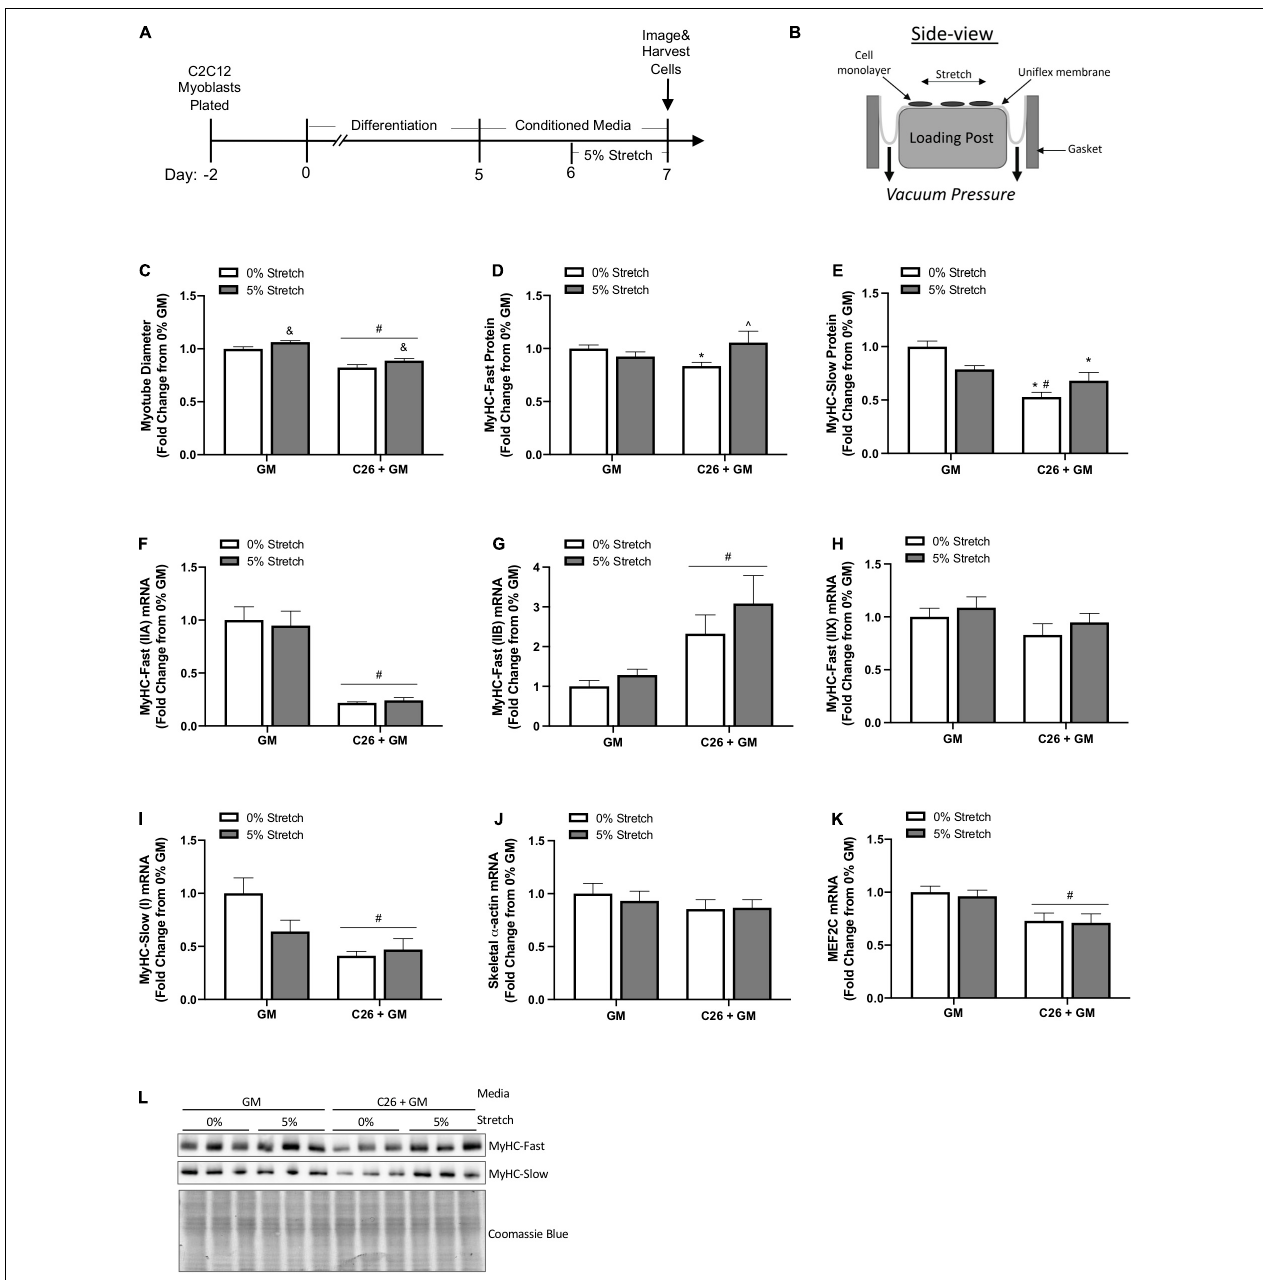
FIGURE 3 | Effects of mechanical stretch on growth and myosin expression in colon-26 (C26)-treated myotubes. (A) Experiment overview: C2C12 myoblasts are plated on in growth media (GM); after 48 h at ∼ 85% confluence, differentiation media is added, which corresponds to day 0. At day 5 of differentiation, fully formed contractile myotubes are present, and conditioned media (CM; GM or C26 + GM) is diluted with 50% serum-free DMEM and added to wells for 48 h. Myotubes are either left unstretched (0%) or stretched 5% in the last 24 h of CM incubation. (B) The side view of the stretching device; cells adhere to the type I collagen coated Uniflex membrane, and a rubber gasket is placed around each six-well plate to create a tight seal; vacuum pressure is applied to deform the membrane around the loading post, which creates a uniaxial stretch (image adapted from Flexcell International). (C) Myotube diameter of unstretched (0%) and stretched (5%) myotubes treated with GM control or C26 + GM ( n = 216 myotubes/group). (D) Myosin heavy chain (MyHC)-Fast (0% n = 18–21/group; 5% n = 9/group) and (E) MyHC-Slow ( n = 9–11/group) protein expression measured by Western blotting. (F) MyHC-Fast (type IIA, Myh2) ( n = 6/group), (G) MyHC-Fast (type IIB, Myh4) ( n = 6/group), (H) MyHC-Fast (type IIX, Myh1) ( n = 6/group), (I) MyHC-Slow (type I, Myh7) ( n = 6/group), (J) skeletal α -actin (Acta1) ( n = 6/group), and (K) Myocyte Enhancer Factor 2C (MEF2C) ( n = 6/group) mRNA expression calculated using 2 − (cid:49)(cid:49) Ct method with GAPDH as a housekeeping gene. (L) Representative Western blotting images with Coomassie blue stain as a protein loading control. Data are presented as means ± SEM as a fold change from GM 0% stretch. Two-way ANOVAs were performed to determine differences. & Main effect of stretch; # main effect of C26 + GM; *significant from GM 0% stretch; # significant from GM 5% stretch; ˆsignificant from C26 + GM 0% stretch. Statistical significance set at p ≤